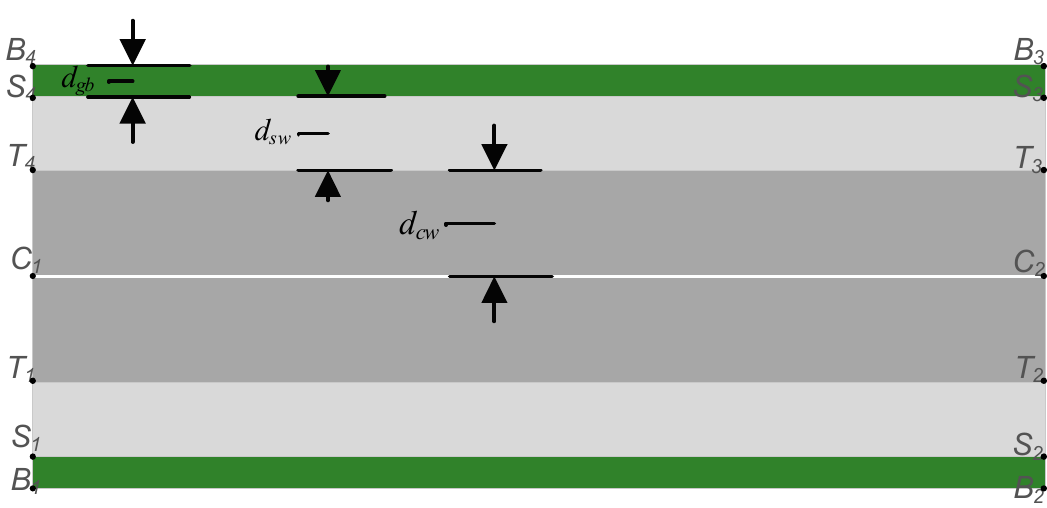
Figure 5. An example of the road template.